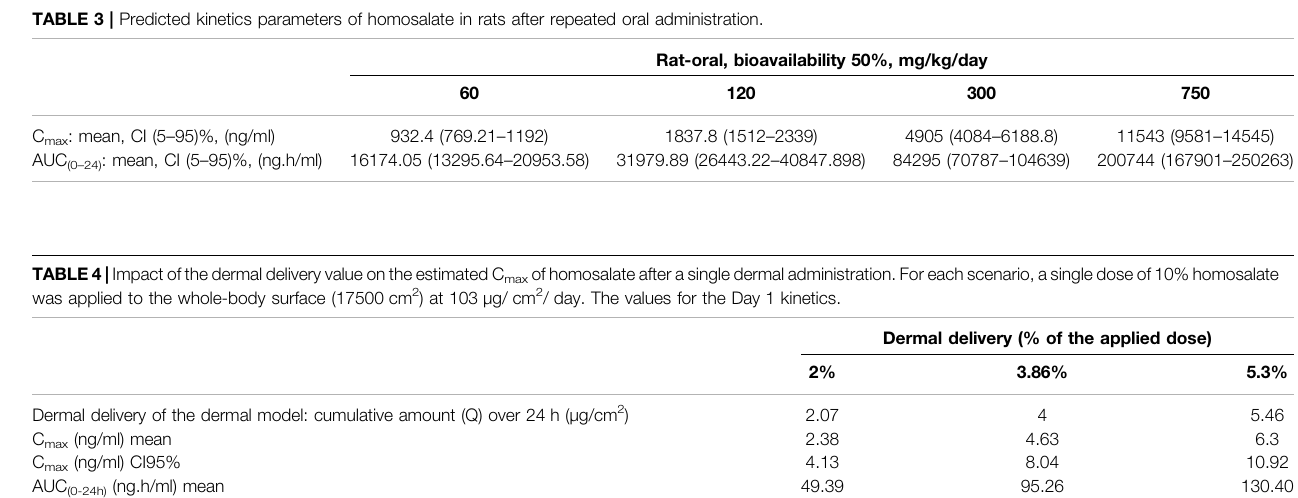
TABLE 3 | Predicted kinetics parameters of homosalate in rats after repeated oral administration.